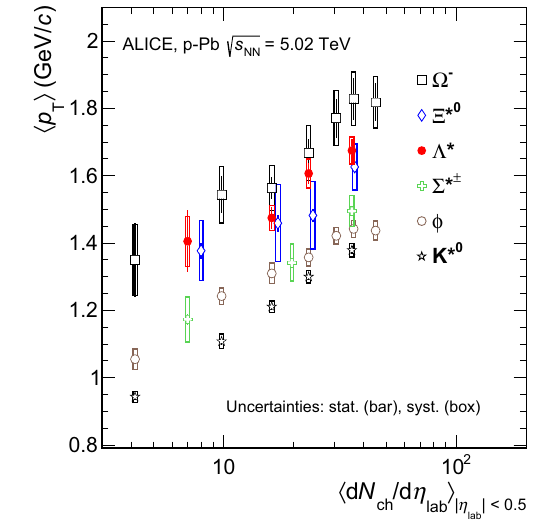
Table 4 Blast wave parameters from fits to π ± , K ± , K 0